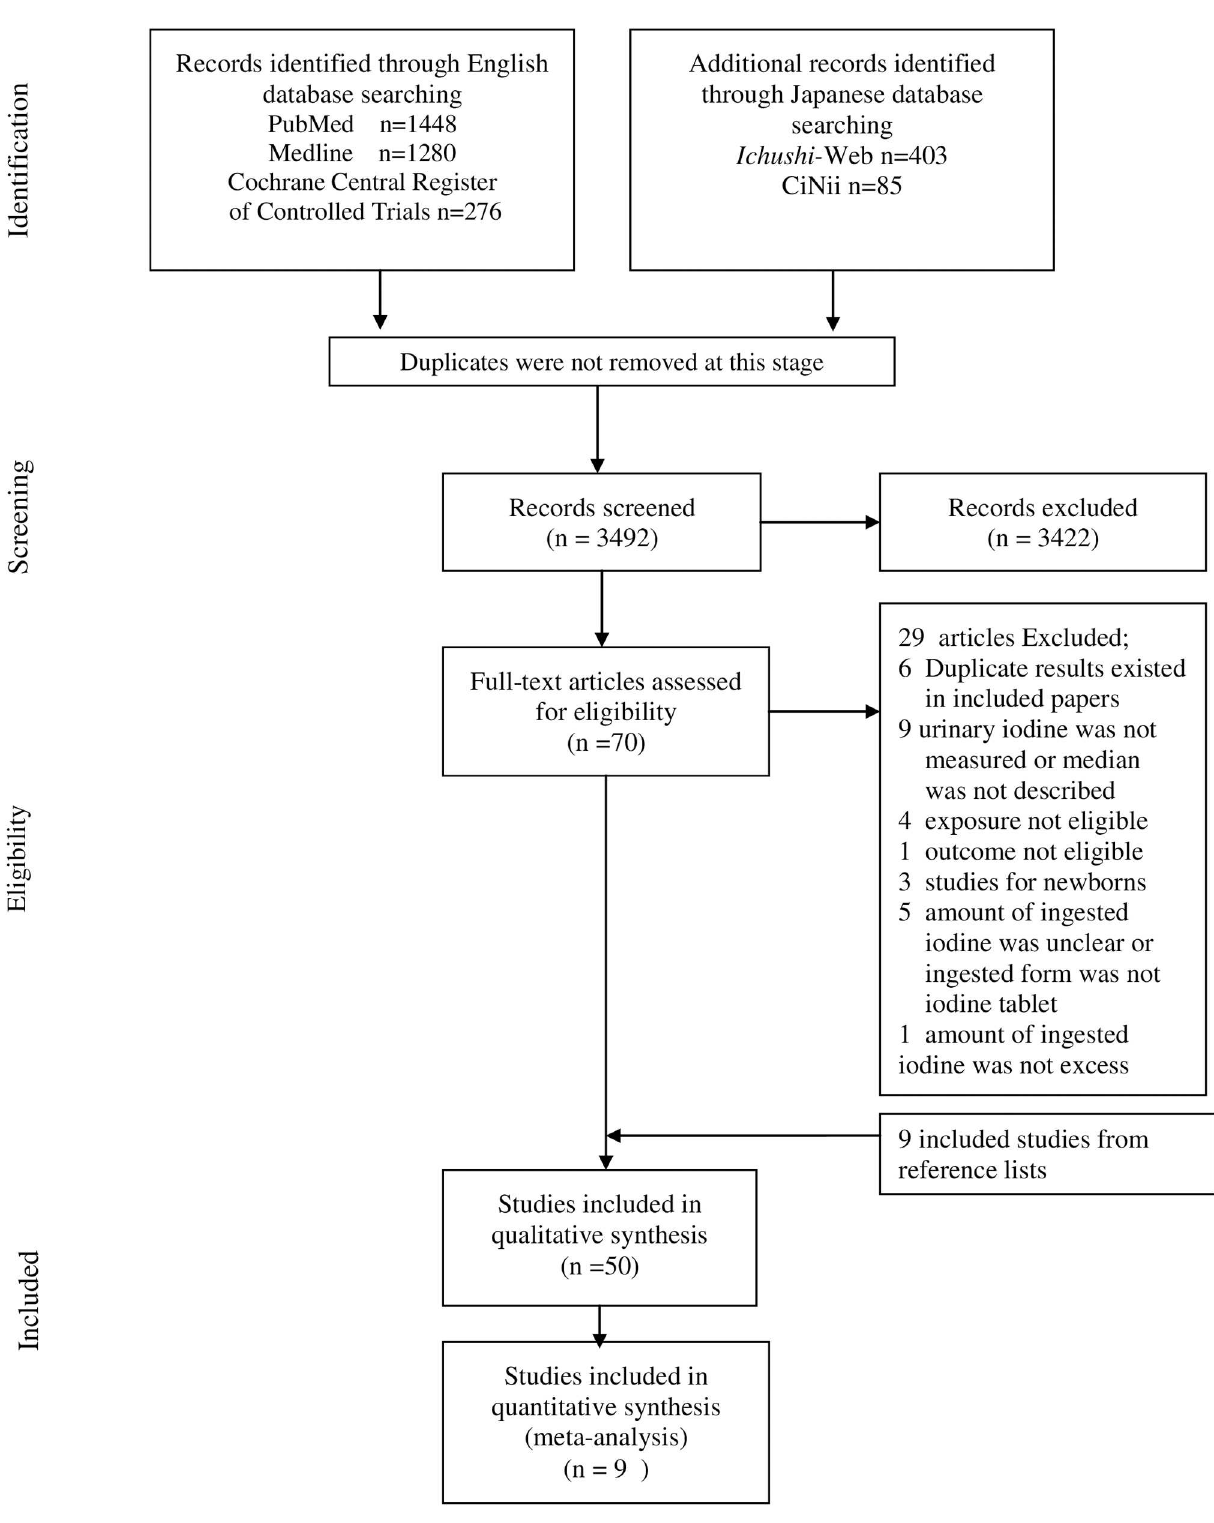
Fig 1. Flow chart of the selection process (searchedon 3 June 2016).